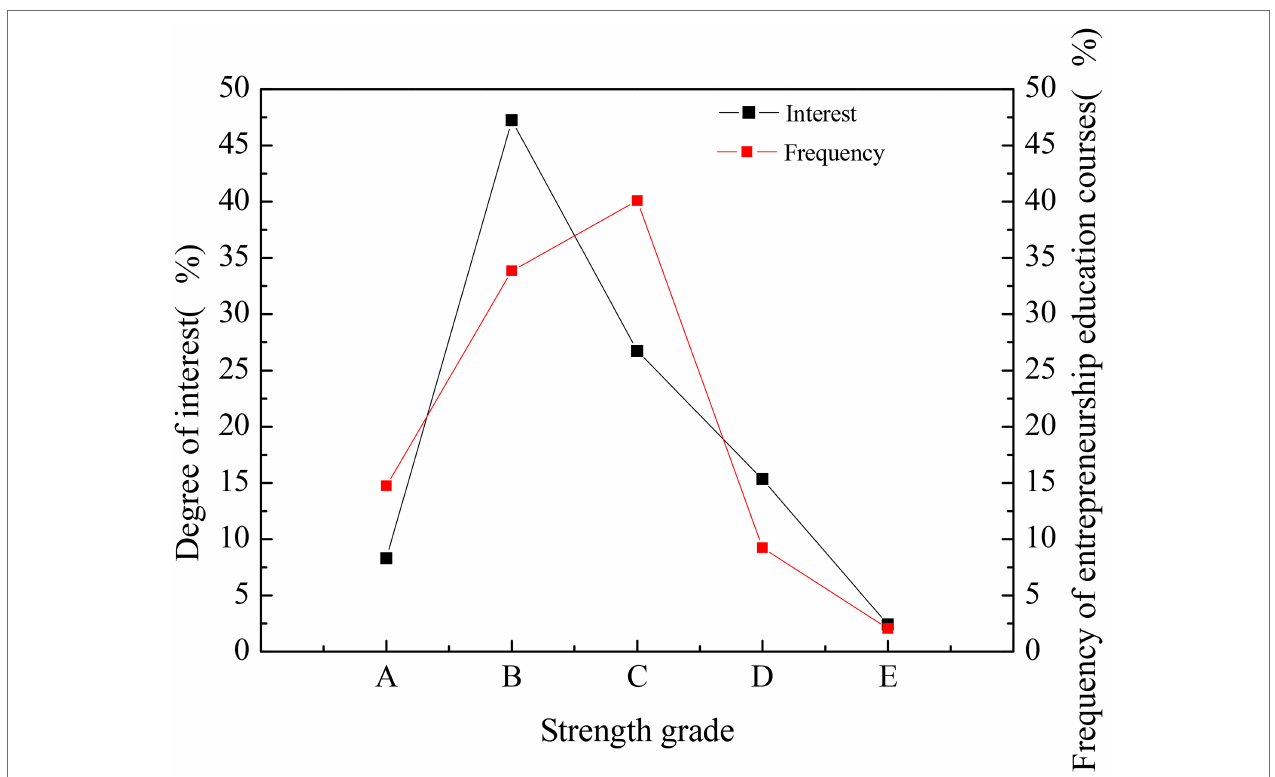
FIGURE 3 | Statistical results of the interest of college students in entrepreneurship education and the frequency of receiving entrepreneurship